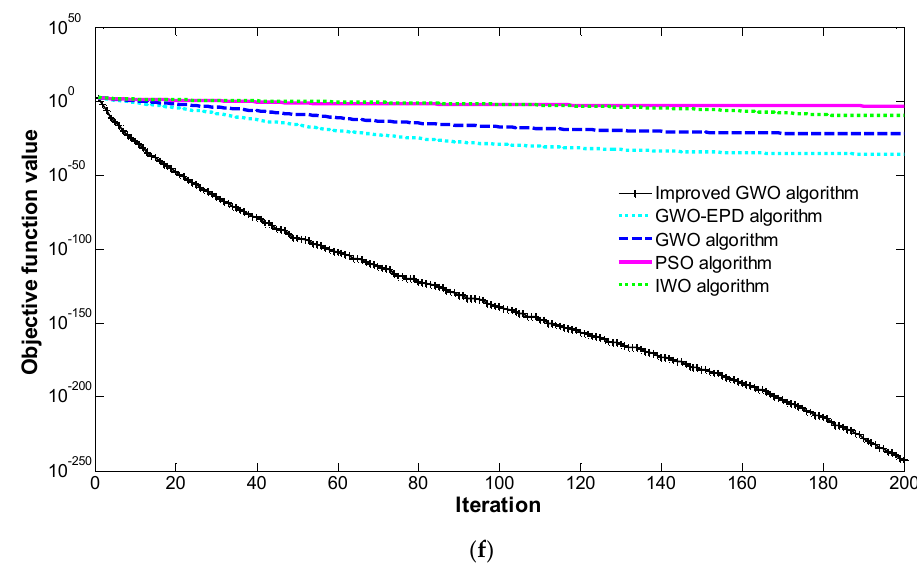
Figure 5. Result comparison of test function 1 ( a ); function 2 ( b ); function 3 ( c ); function 4 ( d ); function 5 ( e ); and function 6 ( f ) with five types of algorithms—the particle swarm optimization (PSO) algorithm, the invasive weed optimization (IWO) algorithm, the GWO algorithm, the improved GWO algorithm, and the GWO/evolutionary population dynamics (GWO-EPD) algorithm.